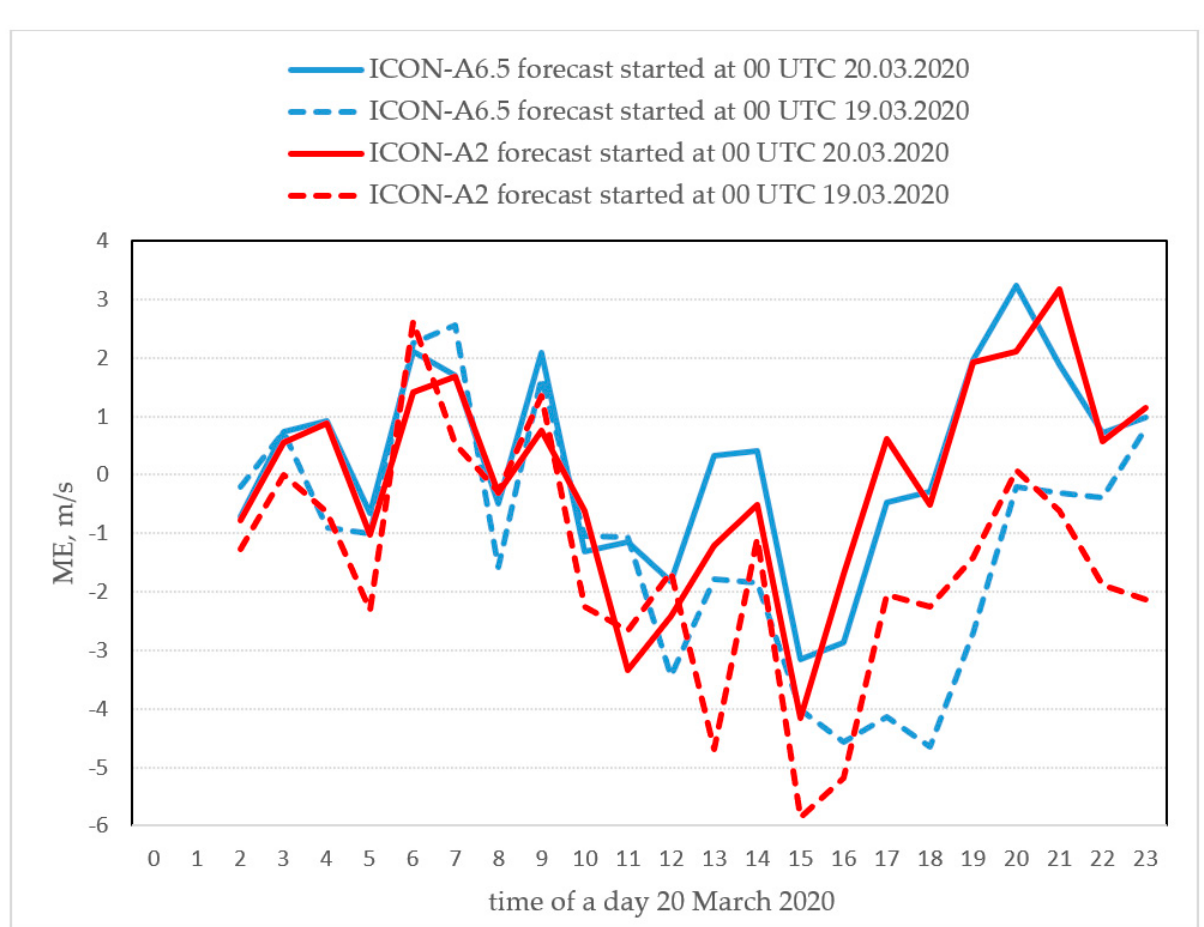
Figure 17. Mean Error (ME) of the ICON ‐ A6.5 (blue) and ICON ‐ A2 (red) forecasts of 10 m wind speed on 20 March 2020, for the forecasts with different lead times: starting at 00 UTC 20 March 2020 (solid line, 24 h forecast) and starting at 00 UTC 19 March 2020 (dotted line, 48 h forecast). ME is presented for three stations: Röst, Skrova, Stokmarknes. Table 1. RMSE of the ICON ‐ A6.5 and ICON ‐ A2 forecasts of 10 m wind speed. Lead Time 24 h, Forecast Started at 00 Stations